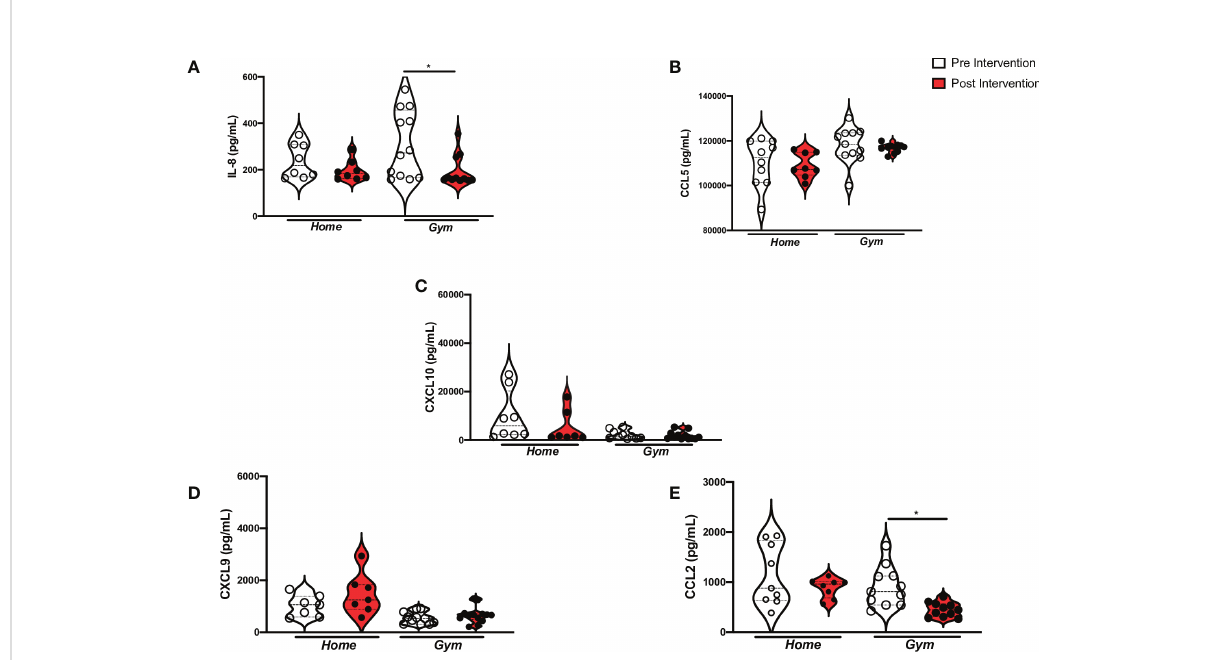
FIGURE 2 Chemokines levels in Supervised and home-based unsupervised exercise on recovered COVID-19 patients. ANOVA between Supervised and home-based unsupervised exercise on the chemokines from baseline to 12 weeks of intervention (Pre- and Post-intervention). Home, the home-based unsupervised exercise group; Gym, supervised exercise group; Serum levels; (A) IL-8: Interleukin- 8 (home (pre), n= 8, home (post), n= 8; gym (pre), n= 13, gym (post), n= 11; p = 0.04); (B) CCL5: CC chemokine family-5 (home (pre), n= 10, home (post), n= 8; gym (pre), n=11, gym (post), n=11; p = n.s.); (C) CXCL10, chemokine (C-X-C motif) ligand-10 (home (pre), n= 8, home (post), n= 7; gym (pre), n= 10, gym (post), n=11; p = n.s.); (D) CXCL9, chemokine (C-X-C motif) ligand-9 (home (pre), n= 8, home (post), n= 8; gym (pre), n= 11, gym (post), n= 13; p = n.s.); (E) CCL2, CC chemokine family-2 (home (pre), n= 10, home (post), n= 10; gym (pre), n= 13, gym (post), n= 12; p = 0.03); pg/mL, picogram per milliliter; *p<